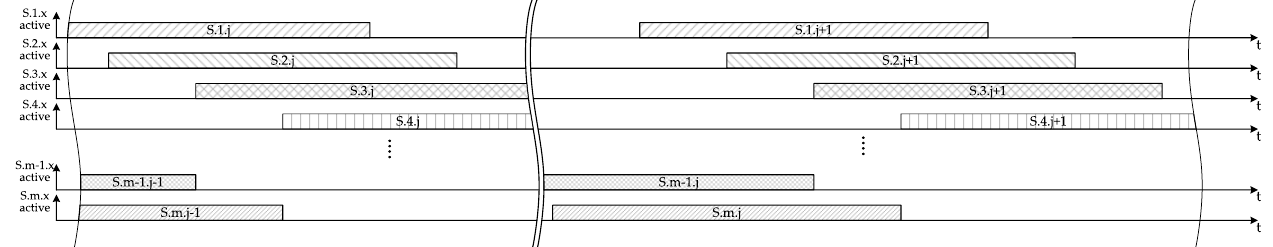
Figure 7. Block diagram of the multi-inverter drive system.